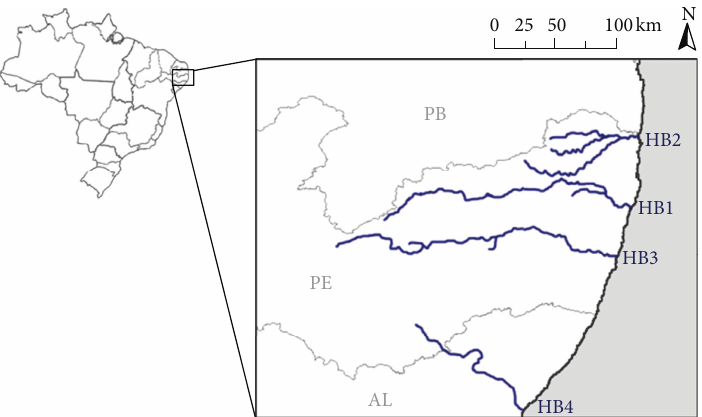
Figure 1: Map of the four hydrographic basins from which Vibrio cholerae O1 was isolated. HB1: Capibaribe hydrographic basin, HB2: Goiana hydrographic basin, HB3: Ipojuca hydrographic basin, HB4: Munda´u hydrographic basin, PE: Pernambuco state, PB: Para´ıba state; AL: Alagoas state.